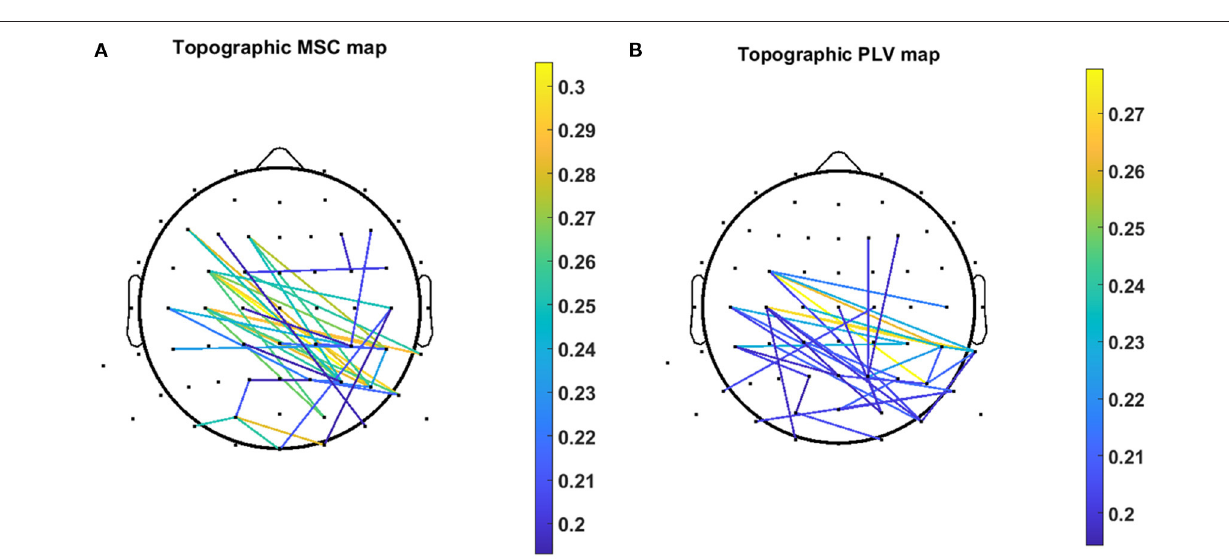
delta band is related to the detection of movement execution or imagination. There are also some research studies investigating PLV in motor tasks. Popovych et al. (2016) found phase